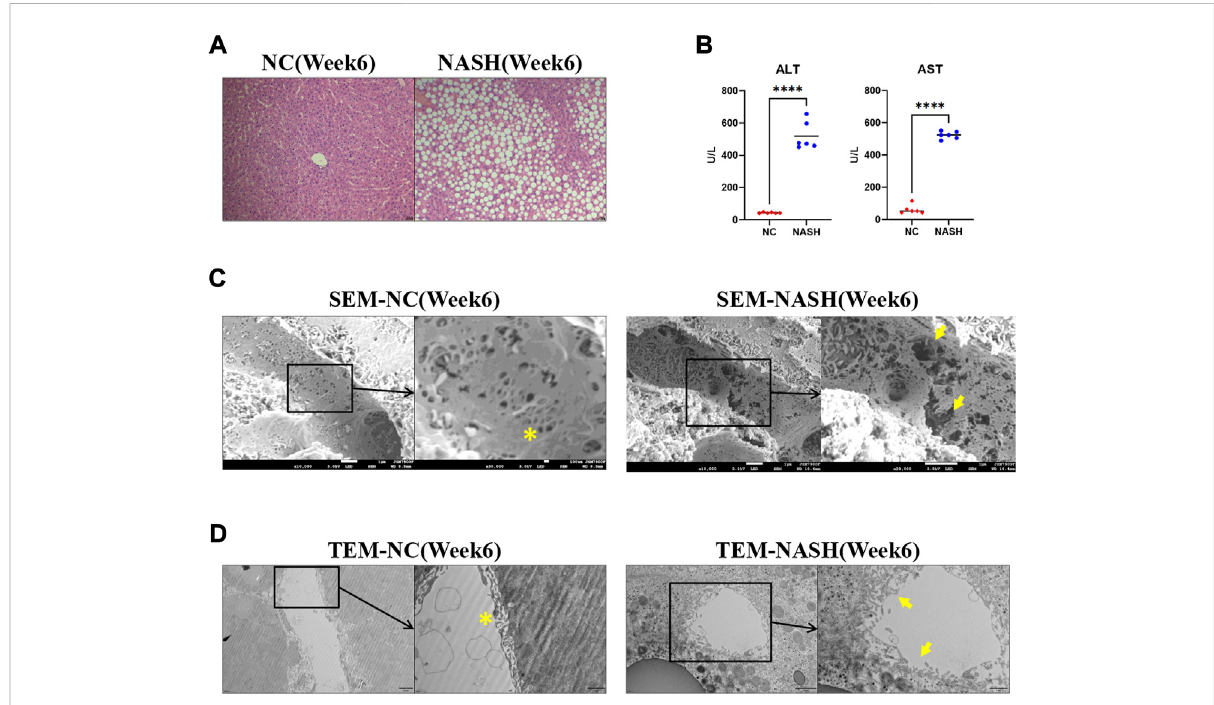
FIGURE 1 LSECs injury in the NASH model. (A) H&E staining was used to evaluate the pathology of the liver in two groups. (B) Alanine aminotransferase (ALT) and aspartate aminotransferase (AST) were tested to evaluate the liver injury. (C,D) Scanning electron microscopy (SEM) and transmission electron microscopy (TEM) showed the ultrastructural features of liver sinusoidal endothelial cells (LSECs) in the normal liver and NASH model. ns, non-signi fi cant; **** p < 0.001 by t -test; n = 6 at each time point per group; fi gures are representative of three